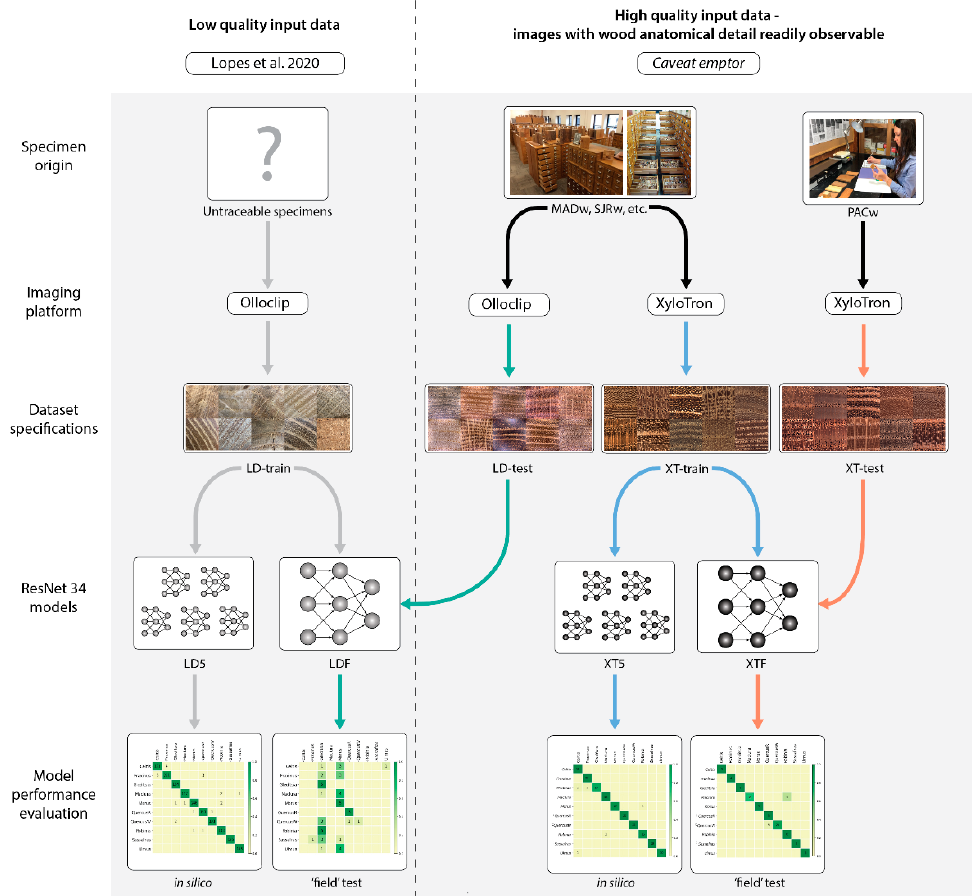
Figure 3. A schematic of the project workflow and the relationships between datasets, models, and evaluations.